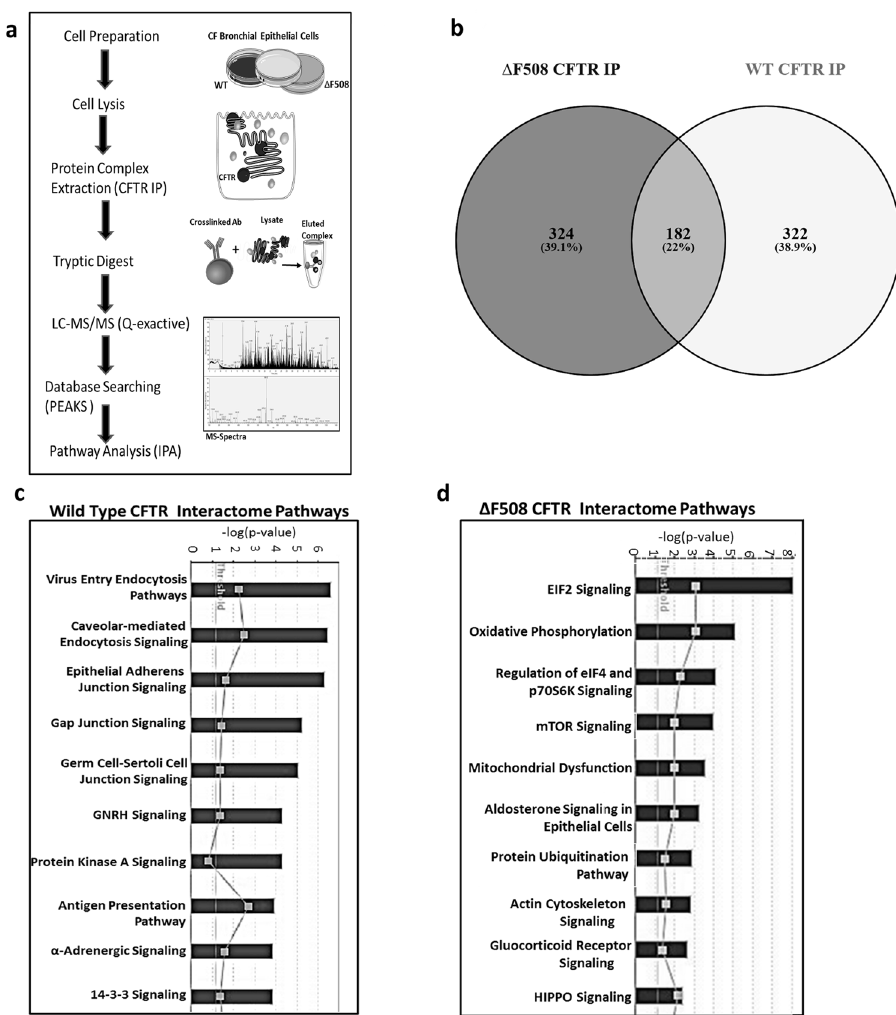
Figure 1. CFTR interactome in HBE41o- and CFBE41o- cells. ( a ) CFTR was isolated from WT HBE41o- and Δ F508 CFBE41o- cells and the resulting CFTR immunocomplexes were subjected to mass spectrometry analysis. An experimental schematic is shown. An experimental schematic is shown. The schematic was produced, in part, by using Servier Medical Art, (www.servier.com/Powerpoint-image-bank). ( b ) The number of proteins identified by mass spectrometry were displayed using Venny Software. Proteins identified in the CFTR interactomes were overlaid onto global molecular networks, developed from information contained in the Ingenuity knowledge database. Canonical pathways significantly associated with proteins (p < 0.05) in the WT CFTR interactome ( c) and Δ F508 CFTR interactome ( d ) are